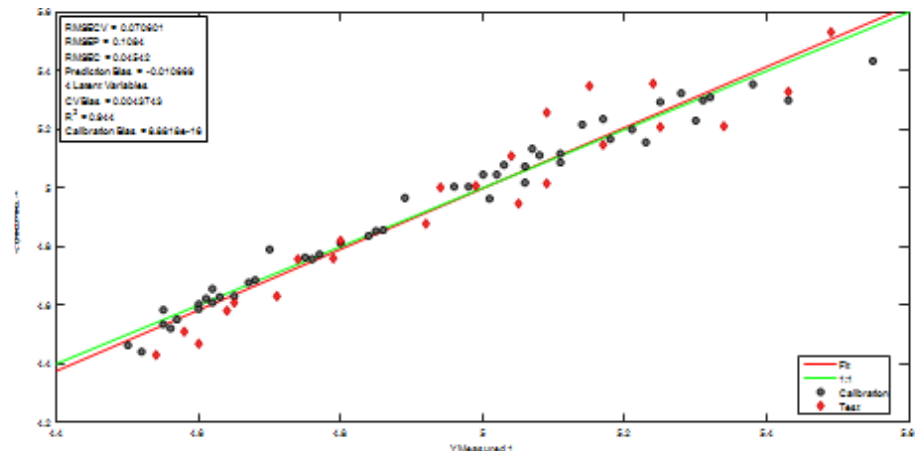
Fig. 8. The PLSR model after SG ¯lter with 15 data points smoothing and FD and OSC pre-treatment and variable selection.